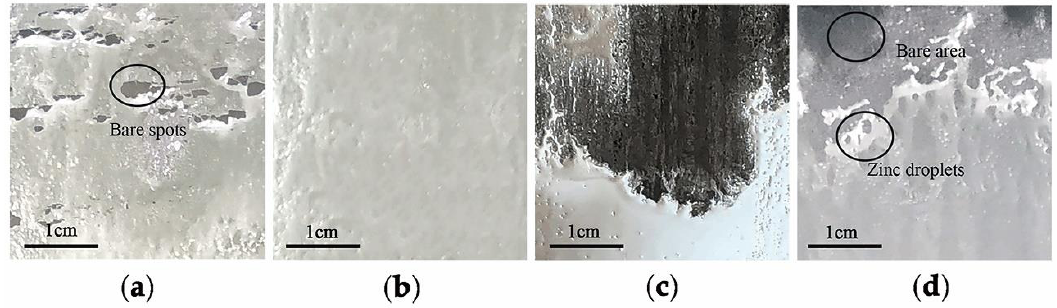
Figure 1. Coating quality of the galvanized medium Mn lightweight steel sheets; ( a ) 3Mn + 10 ◦ C, ( b ) 3Mn − 30 ◦ C, ( c )10Mn + 10 ◦ C, ( d ) 10Mn − 30 ◦